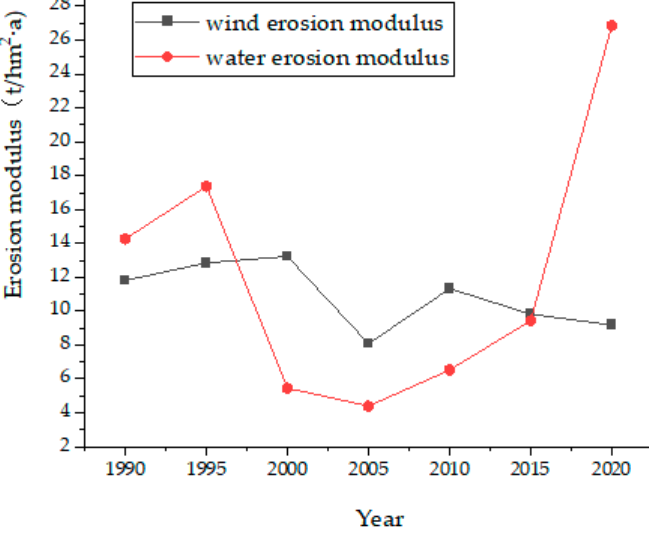
Figure 2. Soil erosion modulus in Baotou City.